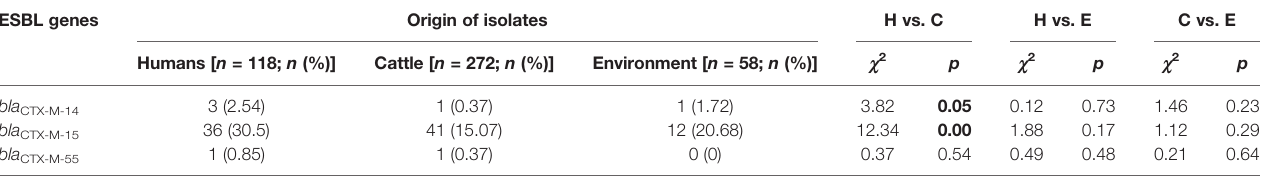
TABLE 2 | ESBL gene variants of isolates originating from abattoir workers, beef cattle, and abattoir environments. ESBL